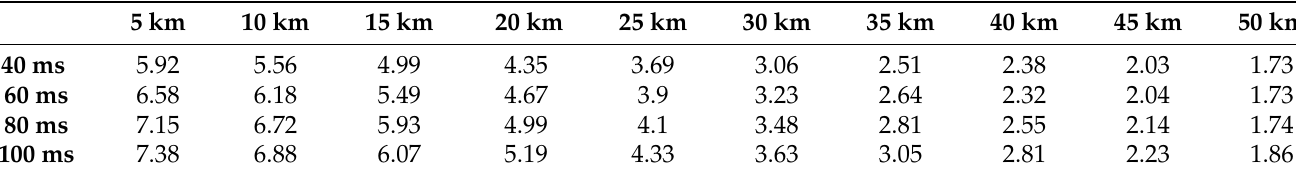
Table 2. Mean LRF values for different integration times at different